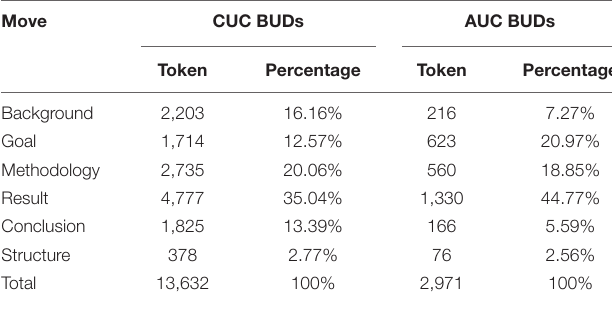
TABLE 6 | Rhetorical move distribution of